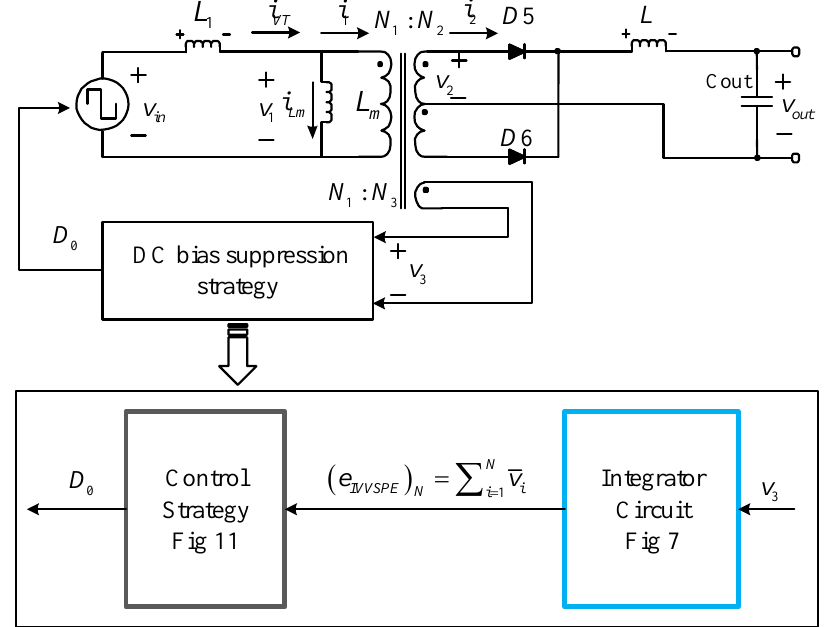
Figure 6. The block diagram of closed-loop control structure with DC bias suppression